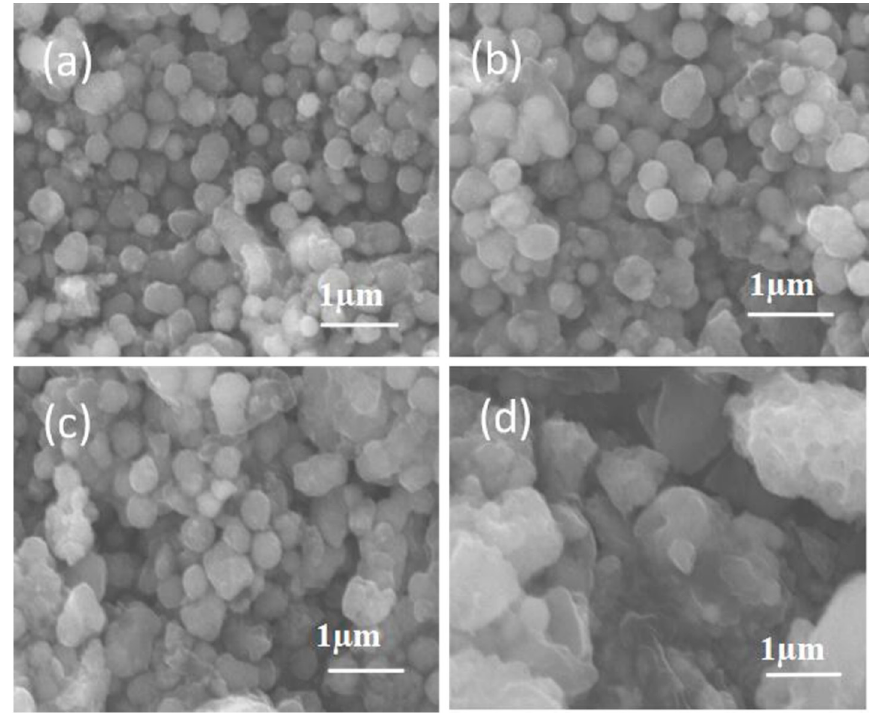
Figure 2. SEM images of Ni-Co-P samples with different ratio from ( a ) 1:1, ( b ) 1:3, ( c ) 1:5, and ( d )